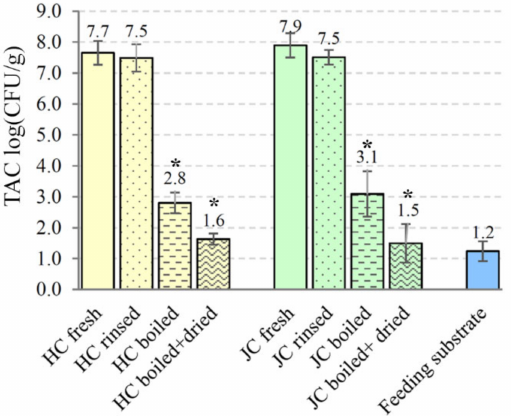
Figure 6. Distribution of the total aerobic plate counts (TAC, log CFU/g) for differently processed A. domesticus and G. assimilis crickets and feeding substrate. HC—house cricket, JC—Jamaican field cricket. All values are the mean of 3 replicates with ± standard deviation (SD). Asterisk above the column indicates statistically significant differences ( p < 0.05) between fresh and processed